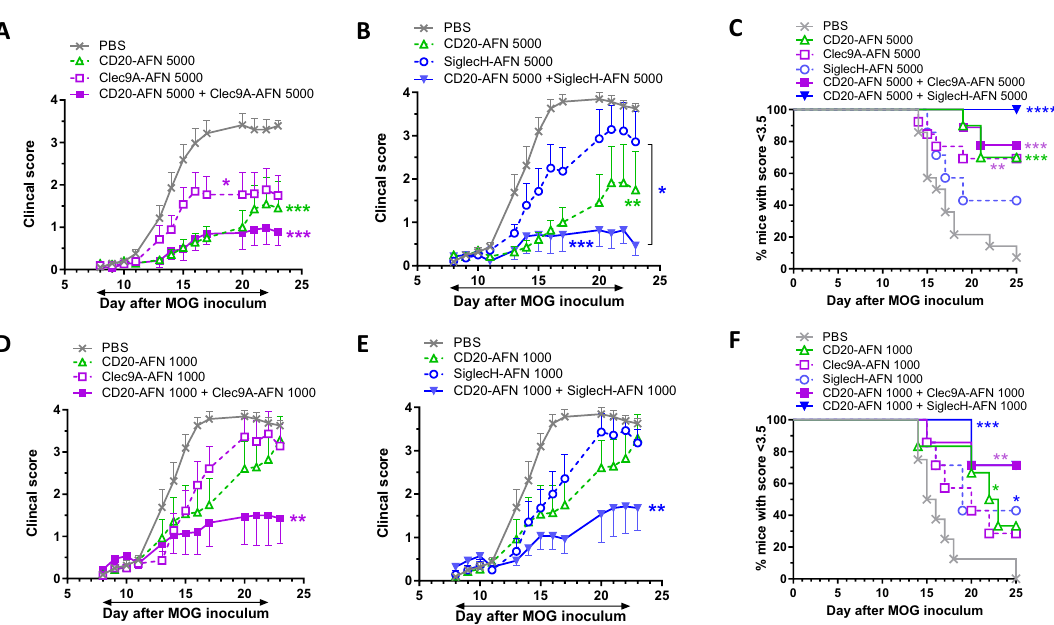
Figure 3. CD20-AFN protects best in combination with SiglecH-AFN therapy. Shown are clinical scores ( A , B , D , E ), or % of severely paralyzed mice ( C , F ). ( A – C ) Mice were treated with 5000 IU AFNs starting d8, ( D – F ) mice were treated with 1000 IU AFNs from d8 on. Shown are 2 pooled experiments (n = 10–12). The black horizontal arrow indicates the treatment period, starting on d8. Differences were assessed using two-way ANOVA followed by Tukey’s multiple-comparison test ( A , B , D , E ), or using Chi Square Log-Rank test for the Kaplan–Meier plots ( C , F ); *P < 0.05, **P < 0.01, ***P < 0.001, ****P < 0.0001, compared with PBS treated animals, unless otherwise indicated ( B